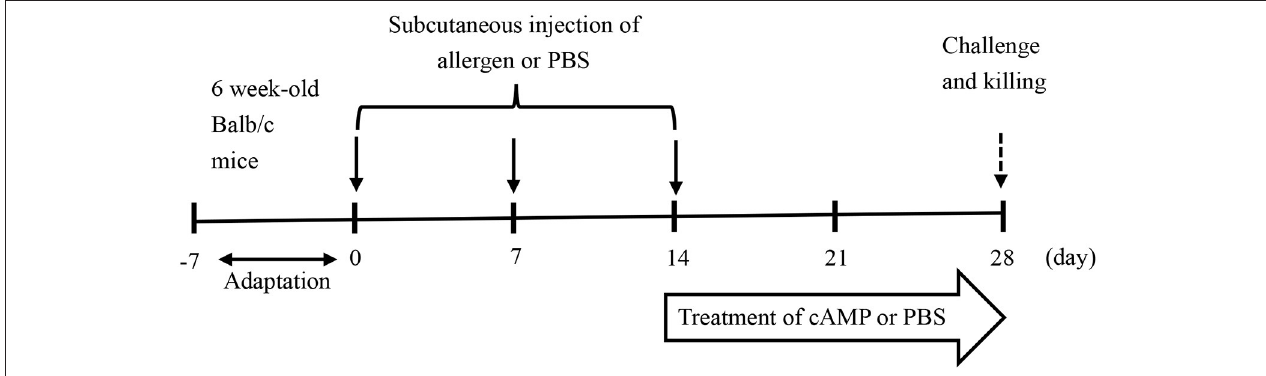
FIGURE 1 | Experimental design of the mouse model of food allergy to peanut. The female Balb/c mice aged 6 weeks were sensitized three times by subcutaneous injections of crude peanut protein extract (PN) (200 µ g/mouse) plus adjuvant of Al(OH) 3 and challenged with PN. In parallel, mice were treated with intragastric cyclic adenosine monophosphate (cAMP) or phosphate-buffered saline (PBS) for 2 weeks.